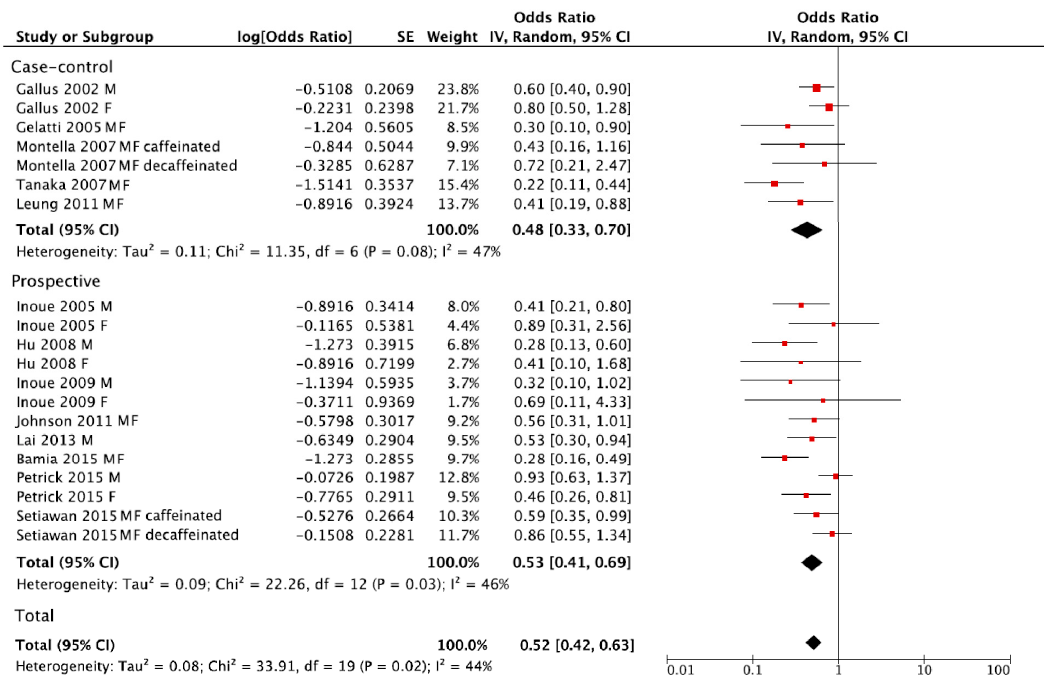
Figure 3. Forest plot of summary relative risks (RRs) of liver cancer for the highest versus lowest (reference) category of coffee consumption, by study design. Table 2. Subgroup analyses of studies reporting risk of liver cancer for the highest versus lowest (reference) category of coffee